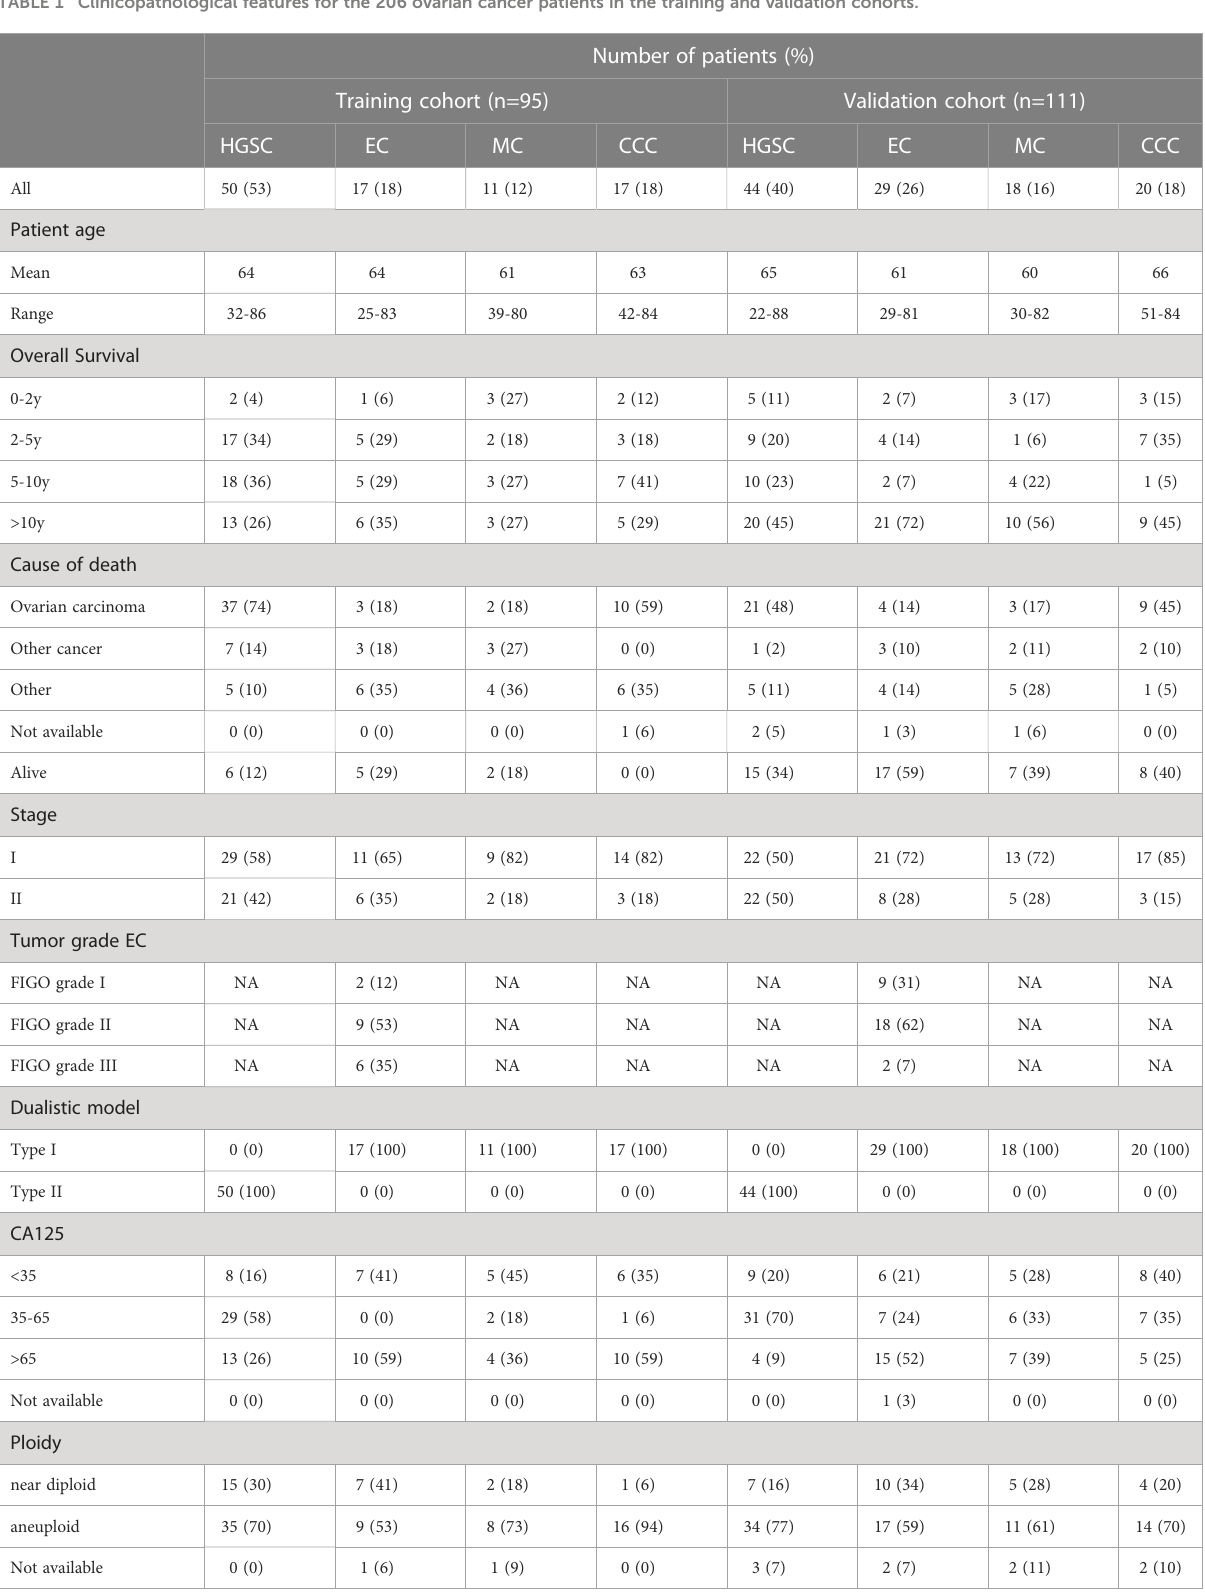
TABLE 1 Clinicopathological features for the 206 ovarian cancer patients in the training and validation